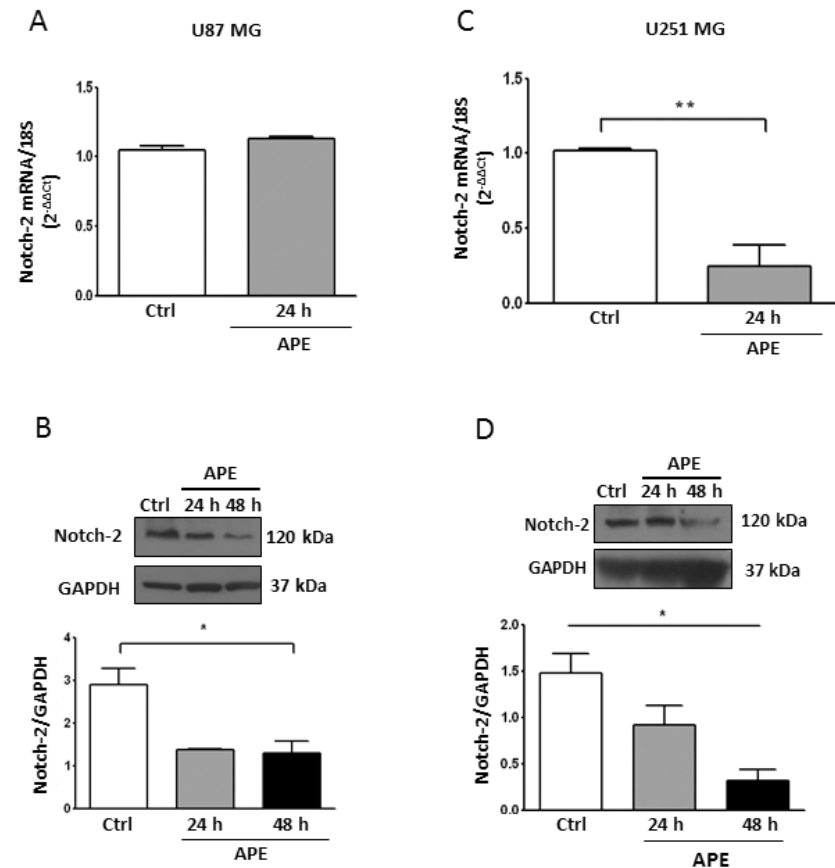
Figure 4. Notch-2 Expression in GBM cell lines. Real time RT-PCR and Western blot analysis ( A , B , respectively) of Notch-2 in U87MG. Parallel analyses were performed in U251MG cells ( C , D , respectively). Both lines were untreated or treated with 100 µ M APE for 24 and 48 h. Representative blots are shown from three independent experiments. GAPDH was used as the internal reference protein. (* p < 0.05 One-way ANOVA test, ** p < 0.01 t